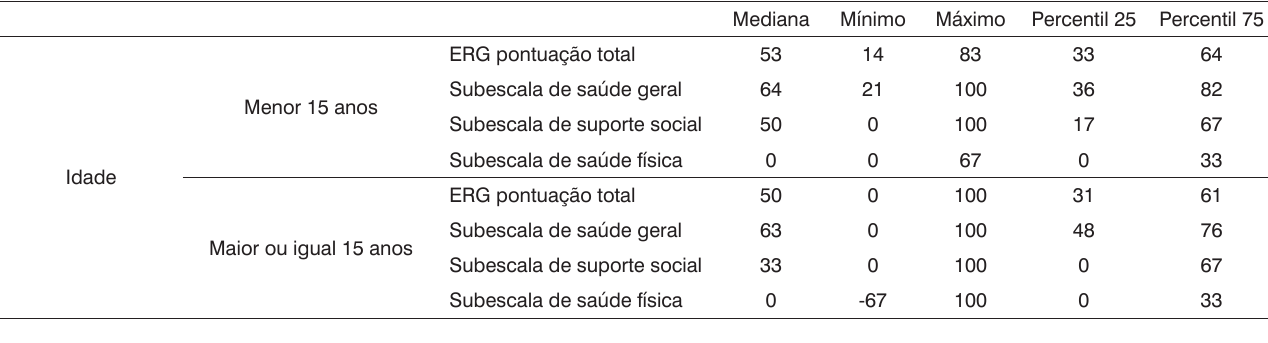
Tabela 2. Valores de mediana conforme faixa